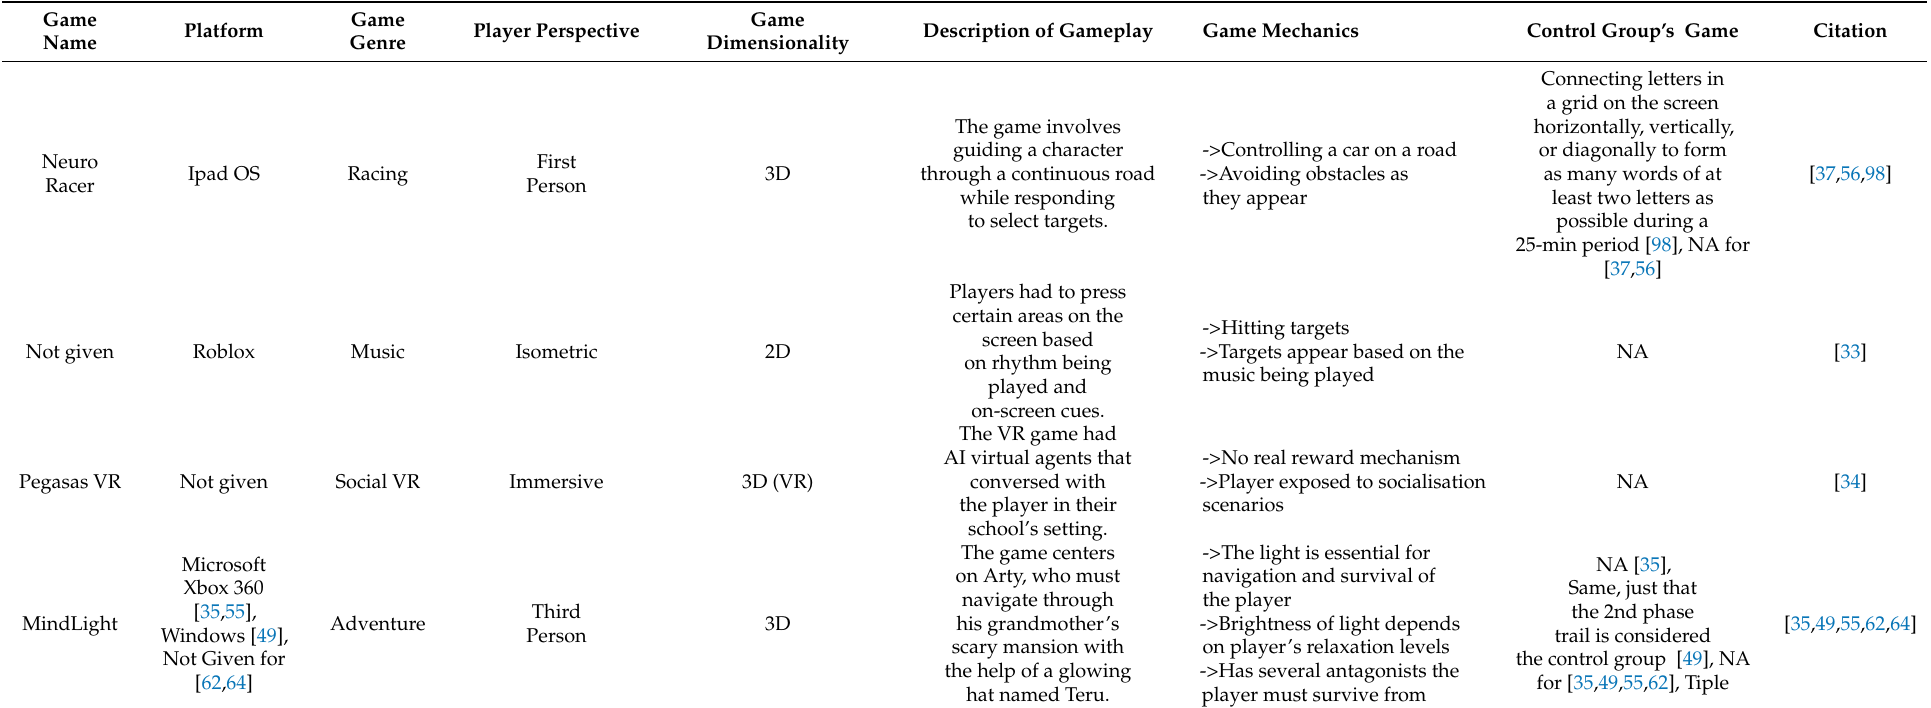
Table 2. Details of the Serious Games used as interventions in the selected